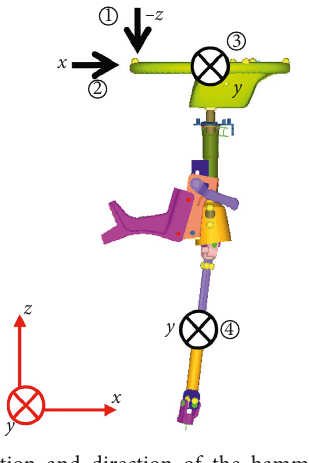
Figure 17: Position and direction of the hammer in the local coordinate system.